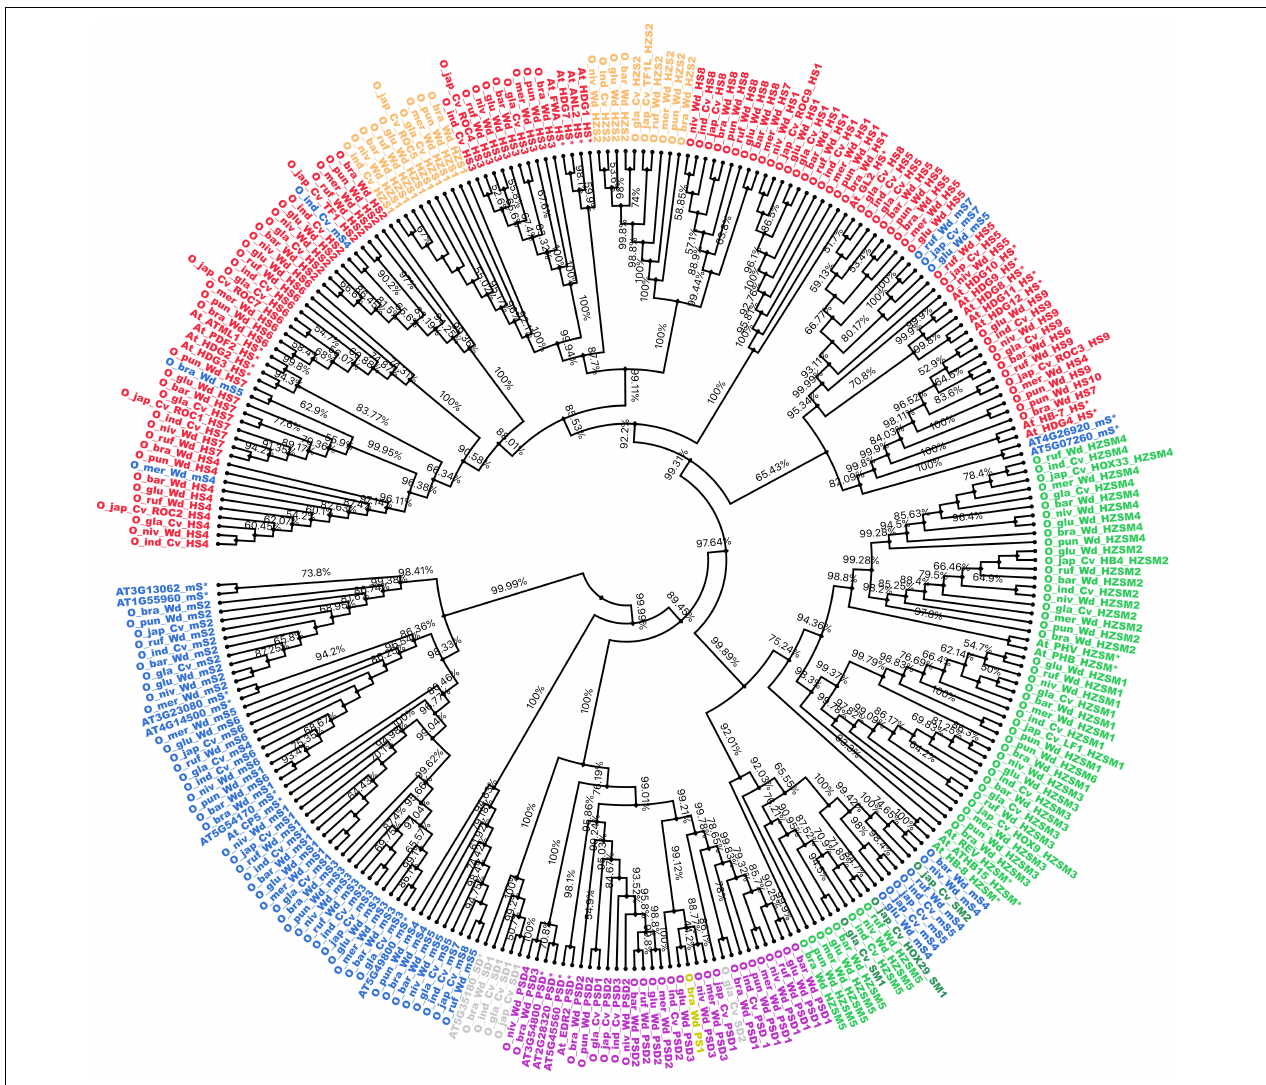
FIGURE 3 | Cladogram for START proteins from all 10 Oryza genomes along with Arabidopsis thaliana (*). Color codes are same as earlier figures: red, HD START (HS); light orange, HD bZIP START (HZS); green, HD bZIP START MEKHLA (HZSM); dark green, START MEKHLA (SM); purple, PH START DUF1336 (PSD); yellow, PH START (PS); gray, START DUF1336 (SD); and blue for minimal START. Phylogeny codes for each locus ID are based on the orthologs analysis with reference to Ojap c as described previously (see Supplementary Table 1